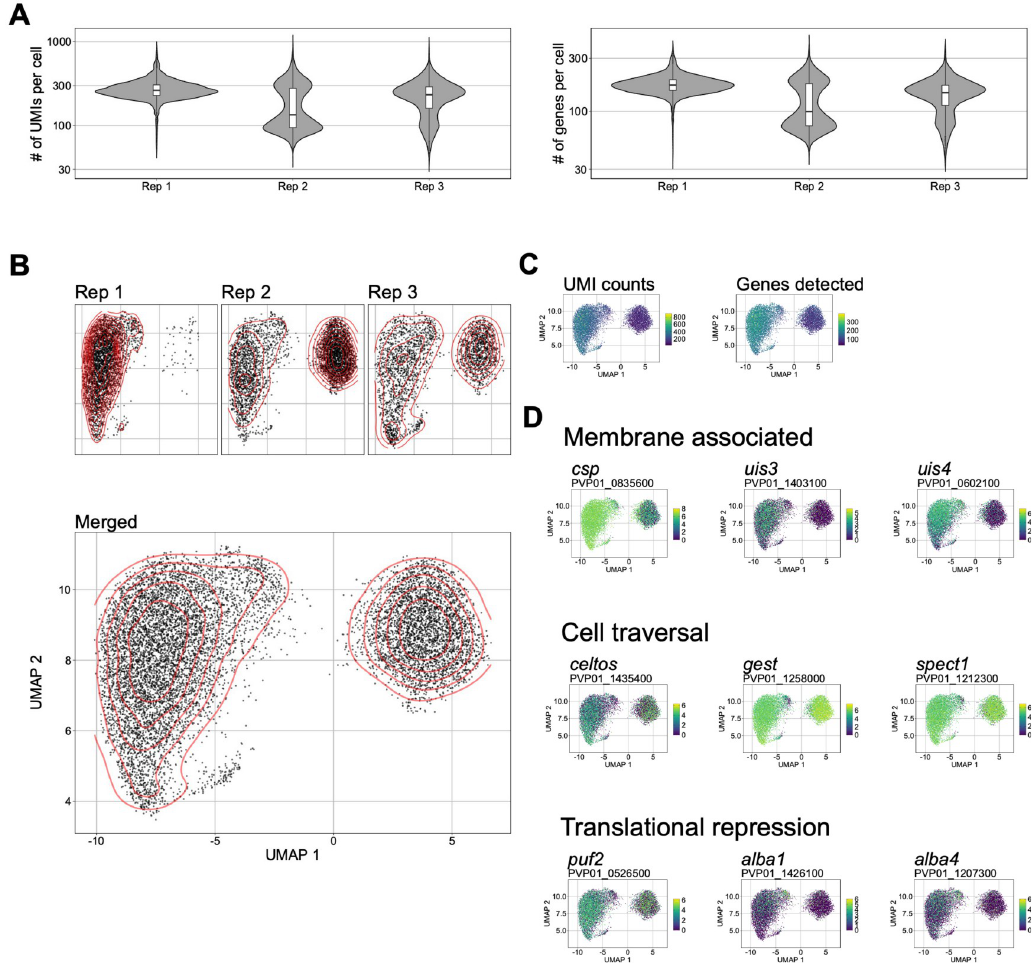
Fig 2. Analysis of P . vivax sporozoite gene expression at single-cell resolution. (A) Violin plots (with boxplox overlaid) showing the distribution of unique molecular identifiers (UMIs) per cell (left), and genes detected be cell (right). (B) UMAPs of P . vivax sporozoite transcriptomes, visualized per replicate (upper) and combined (lower). Red-lines represent the density of cells represented in low dimensional space. (C) UMAPs of P . vivax transcriptomes colored by total number of UMIs (left) and total number of genes detected (right) per cell. (D) UMAPs of P . vivax sporozoite transcriptomes. Cells colored by expression of various genes implicated in sporozoite biology. Scale bar: normalised expression. csp : circumsporozoite protein; uis3 : upregulated-in-infective sporozoites 3; uis4 : upregulated-in-infective sporozoites 4; celtos : cell-traversal protein for ookinetes and sporozoites; gest : gamete egress and sporozoite traversal; spect1 : sporozoite microneme protein essential for cell traversal 1; puf2 : mRNA-binding protein PUF2; alba1 : DNA/RNA binding protein Alba1; alba4 : DNA/RNA binding protein alba4. sporozoites [22,25]. C2 markers included circumsporozoite protein (PVP01_0835600); early transcribed membrane protein (PVP01_0602100); TRAP-like protein (PVP01_1132600); and sporozoite surface protein essential for liver stage development (PVP01_0938800) (Fig 3C and S6 Table). Relative to C1 and C2, C3 had the fewest markers (20) (adjusted p-value < 0.05), and of the markers identified, their changes in transcription were modest (average log change range 0.28–0.84; S4B Fig). Markers in this cluster included genes involved in proton transport (PVP01_0317600 and PVP01_1117400); redox response (PVP01_0835700 and PVP01_1249700); and heat shock proteins (PVP01_1440500 and PVP01_1011500) (Fig 3C and S6 Table).